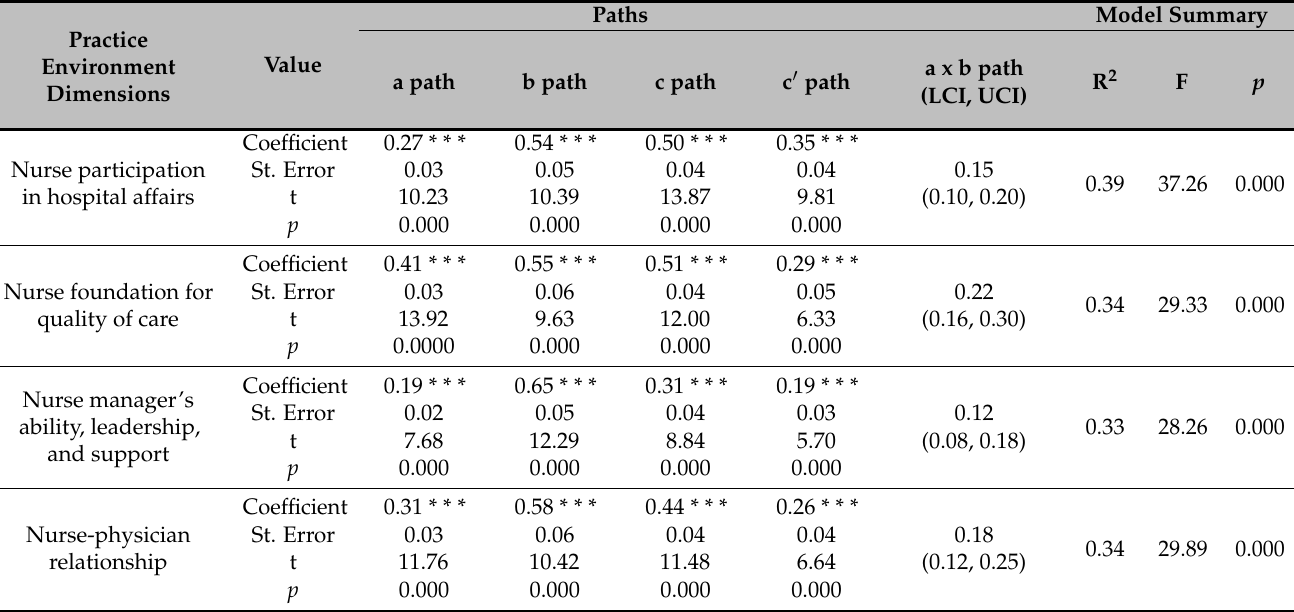
Table 3. The Mediation Effect of Person-Centeredness on the Quality of Care.